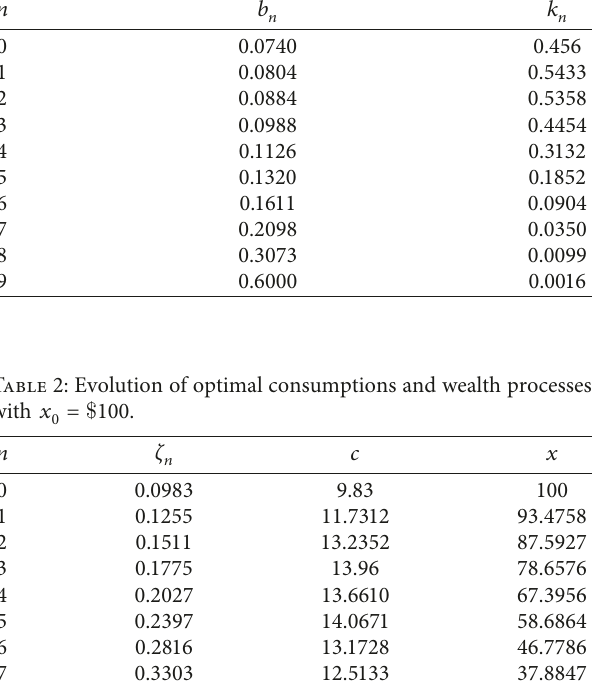
Table 1: Values of b